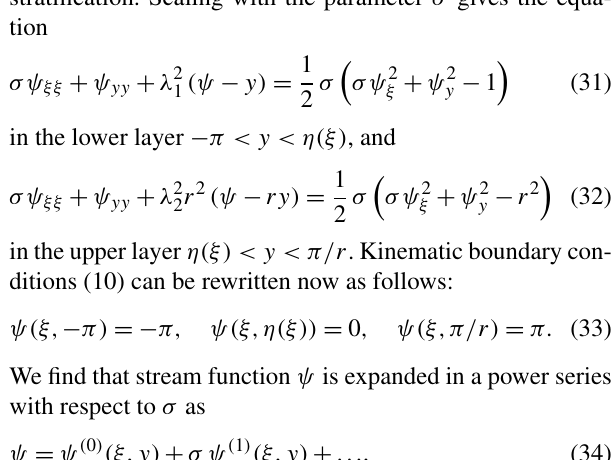
parameters are small in the case of low stratification.